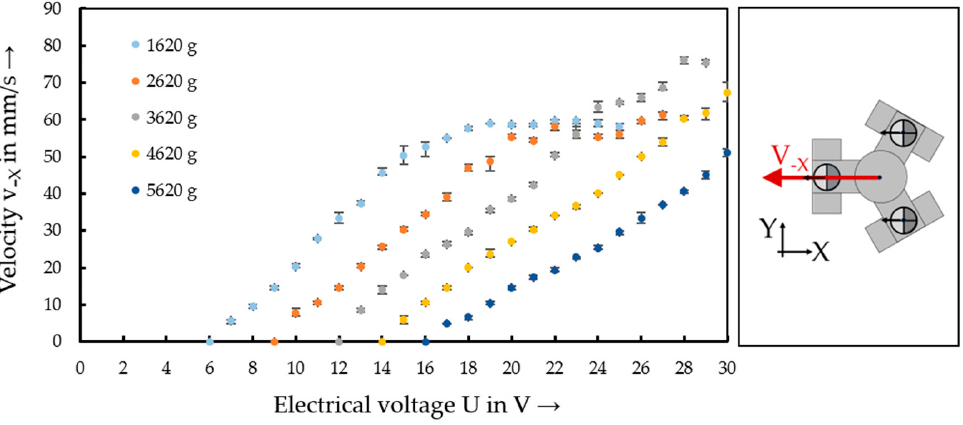
Figure 9. Measurement results of the maximum drive velocity 𝑣(cid:3548) (cid:2879)(cid:3025) of the planar motor platform in the − X direction for different transport load scenarios. Table 2. Appropriate operating ranges for velocity in the − X direction.